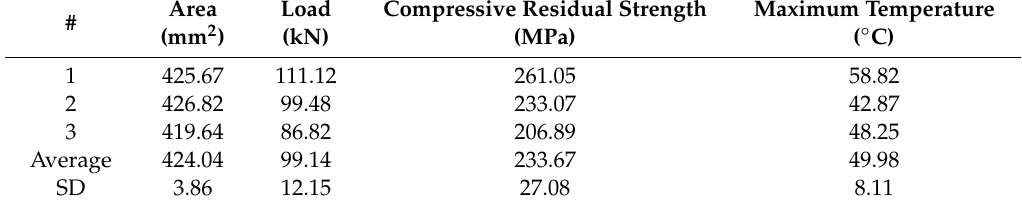
Table 11. CAI test results of Type 1-0 (without impact test).